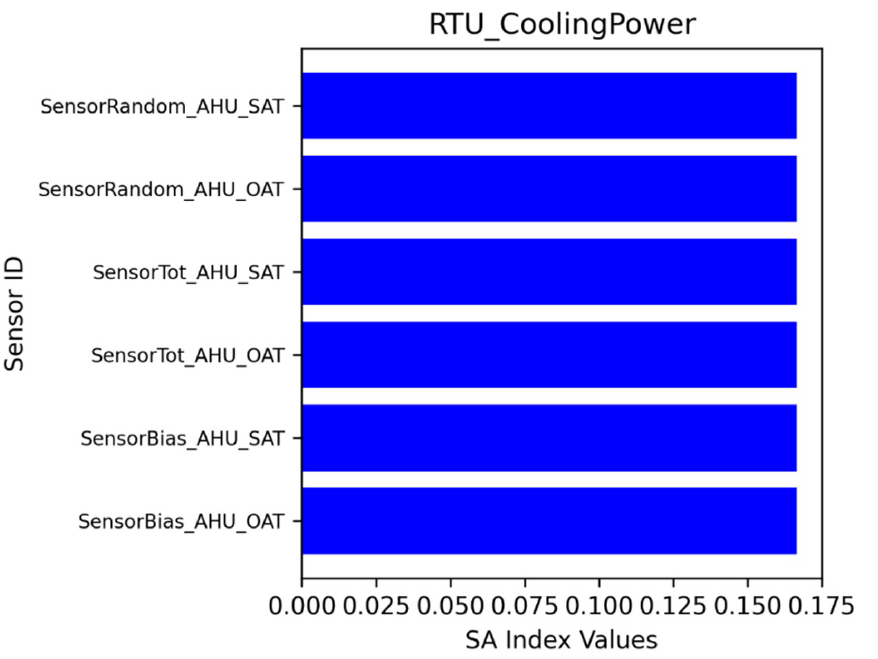
Figure 17. SA for RTU cooling power.